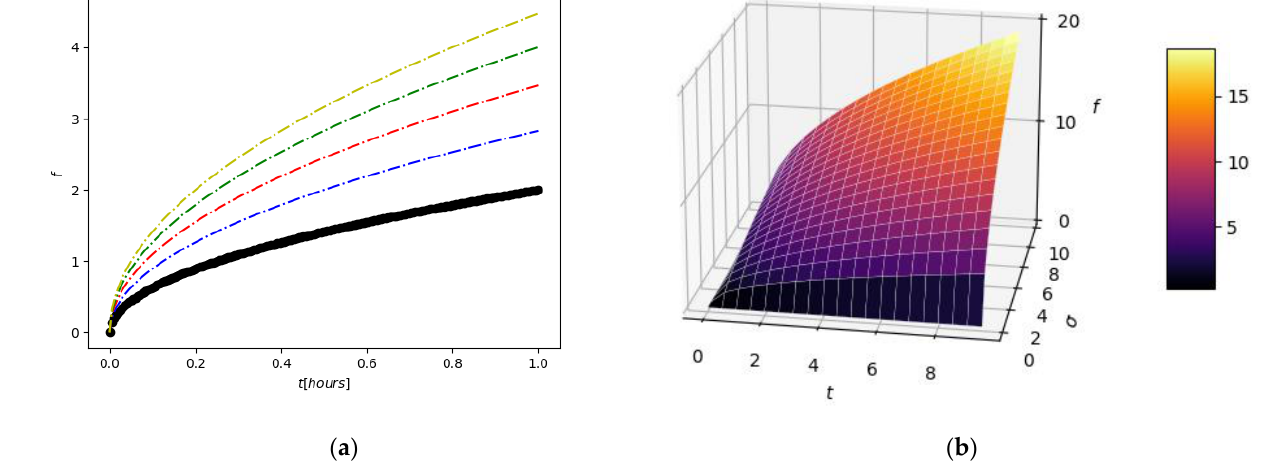
Figure 4. Two-dimensional contour ( a ) and three-dimensional plot ( b ) representations of f multifractal function.